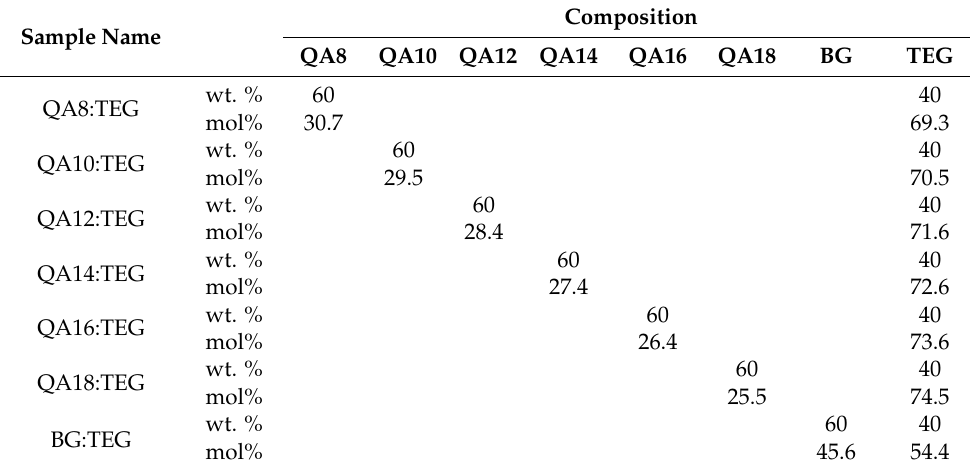
Table 1. The sample names and compositions. The QAUDMA monomers are abbreviated to QA, accompanied by a number which represents the number of carbon atoms in the N-alkyl substituent. Bis-GMA is abbreviated as BG, and TEGDMA is abbreviated as TEG.